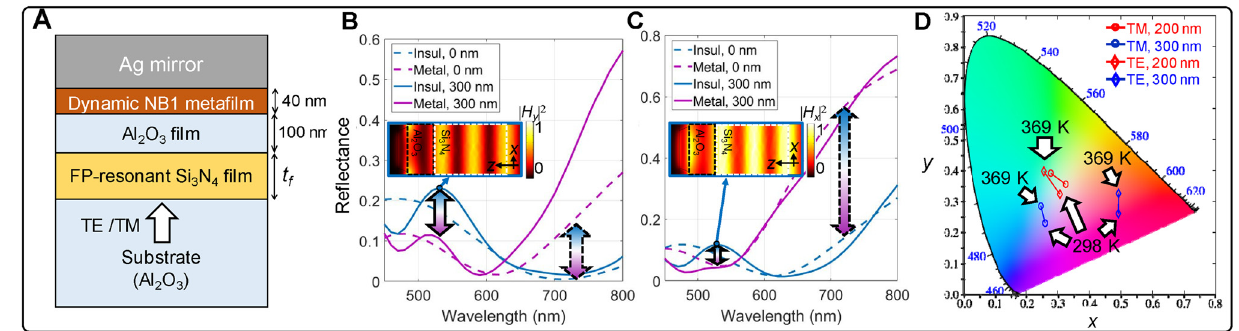
Figure 7: Dynamic metafilm heterostructure absorber: extensibility of the phase-change metafilm for extraordinary spectrum tunability. (A) Schematicillustration of of Si 3 N 4 fi lm inserted PCMA heterostructure using the NB1 meta fi lm. Phase-change tunability of device described under (B) TM and (C) TE illuminations, respectively. Sub- fi gures of (B, C) present spatial intensity pro fi les of H y and H x fi elds at the re fl